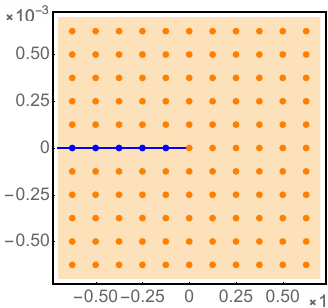
Figure 6. The convergence of G on the complex plane of s = zu A e { t 0 . The orange/blue dots correspond to numerical tests where G can/cannot converge, indicating whether the corresponding W ( t 1 , t 2 ) is well-defined for all t 1 , t 2 . The result shows that W is well-defined for | arg s | < π , which serves as evidence that F R ( z ; π + it 1 , − π + it 2 ) is analytic for | arg z | < π . This has been tested for 2 2 q = 4 , 6 with βJ = 1 , 4 , 8 , 15